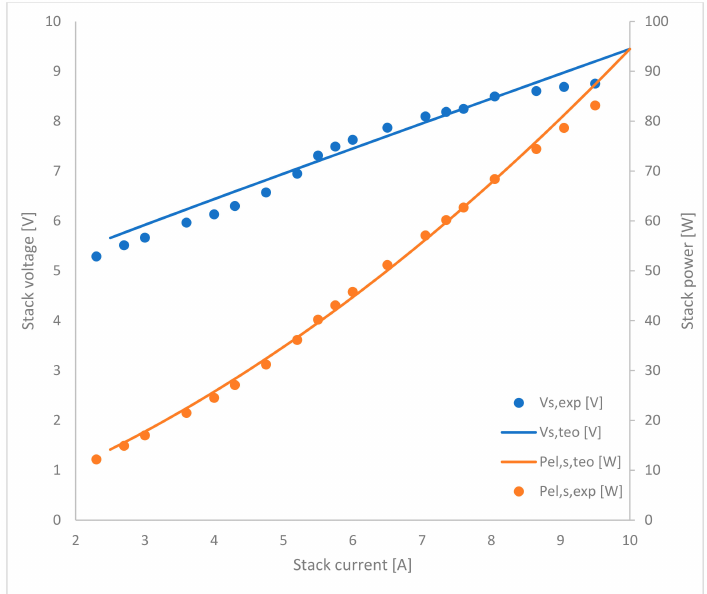
Figure 4. Comparison between the PEM electrolytic stack’s theoretical polarization and electric power curves ( V s,teo and P el,s,teo ) and PEM electrolytic stack’s corresponding experimental data ( V s,exp and P el,s,exp ).